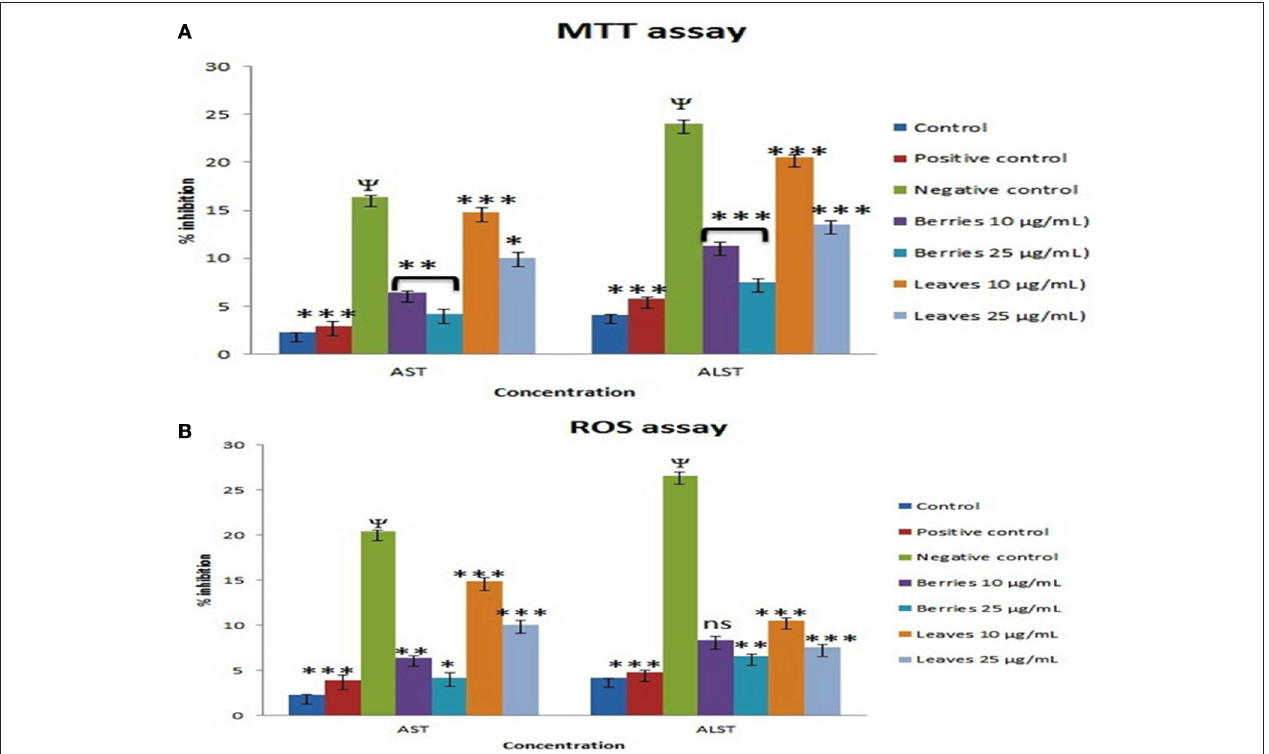
FIGURE 6 | Effect of SGAs enriched fraction on hepatic marker enzyme by (A) , MTT and (B) , ROS. Each value is represented as mean ± SEM, n = 6, 9 P < 0.01 when toxic control compare with control, ns, Non significance. * P > 0.05, ** P < 0.01, *** P < 0.001 vs. toxic control, One way ANOVA followed by Dunet’s